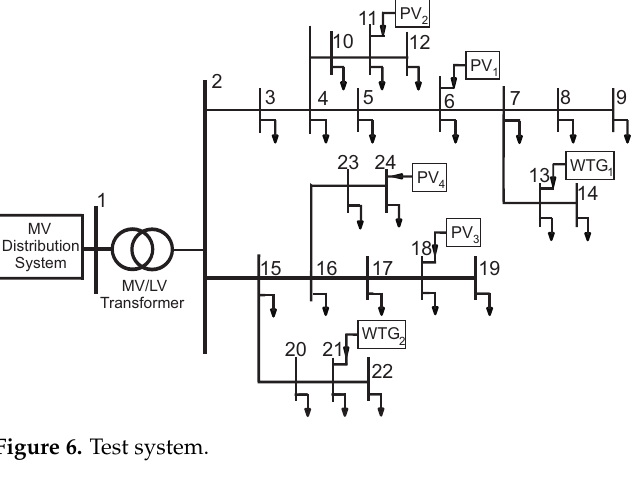
Figure 6. Test system.